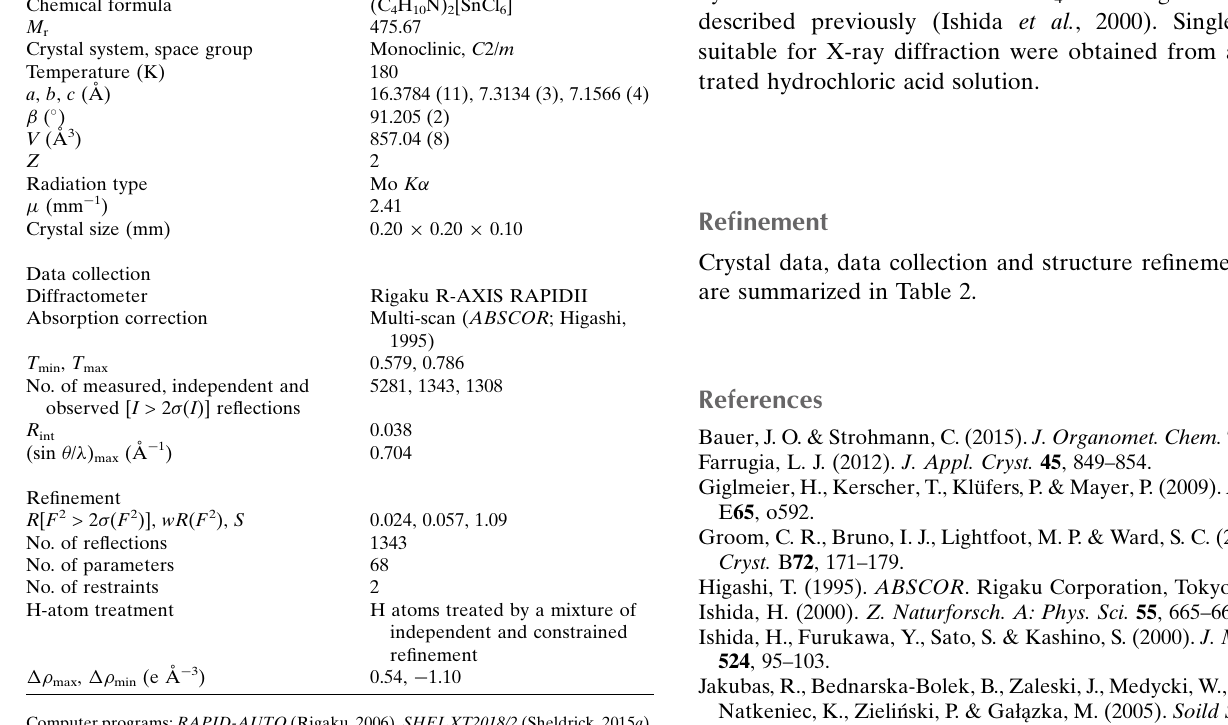
Crystal data Chemical